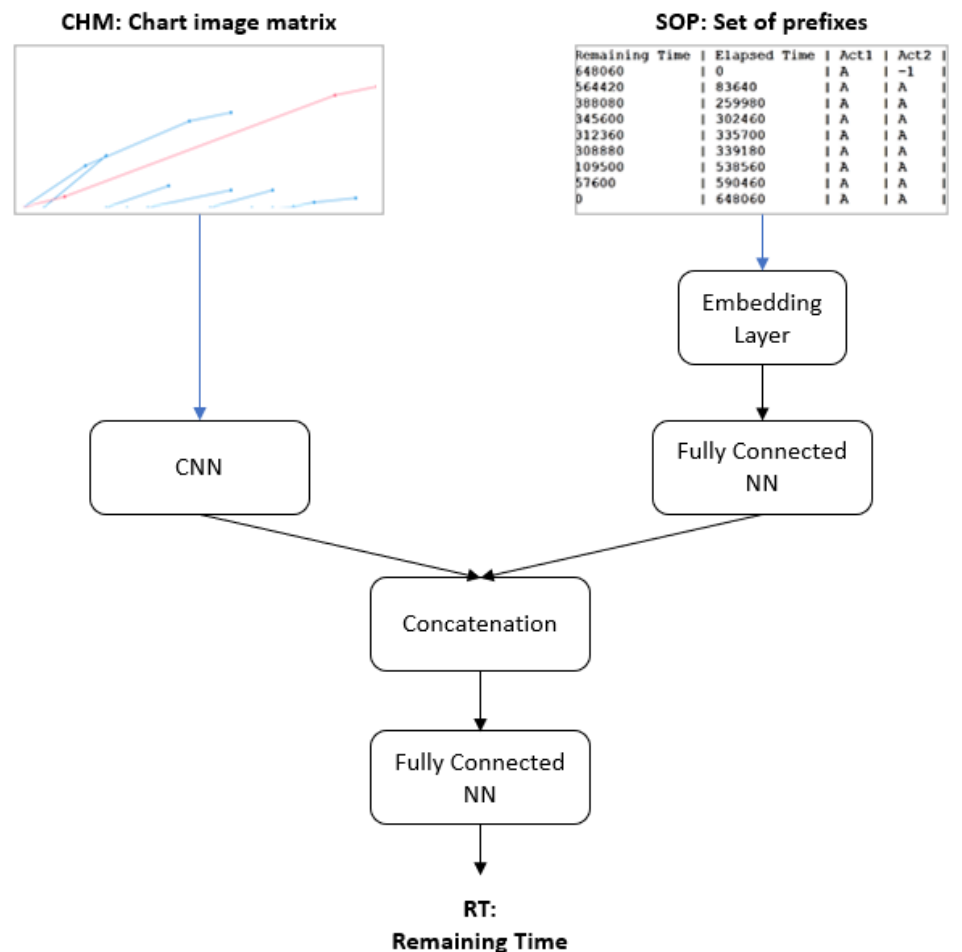
Figure 1. The general framework of the proposed deep-learning model.